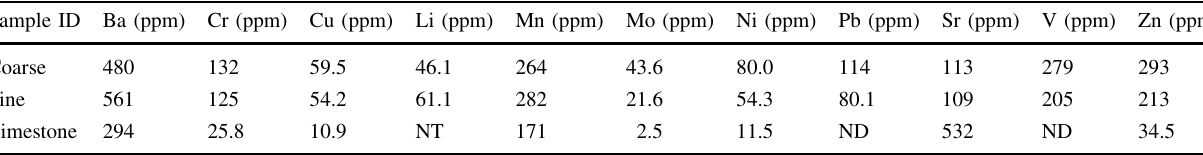
Table 4 Comparison of trace elements in coal waste HTA and ground limestone